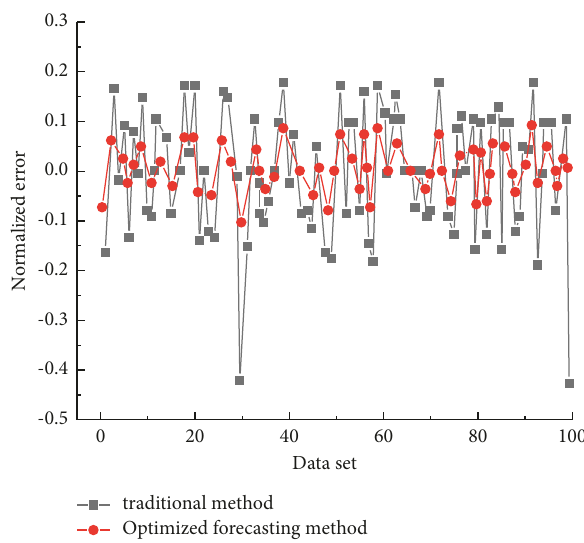
Figure 11: Comparison of training errors of the two methods.